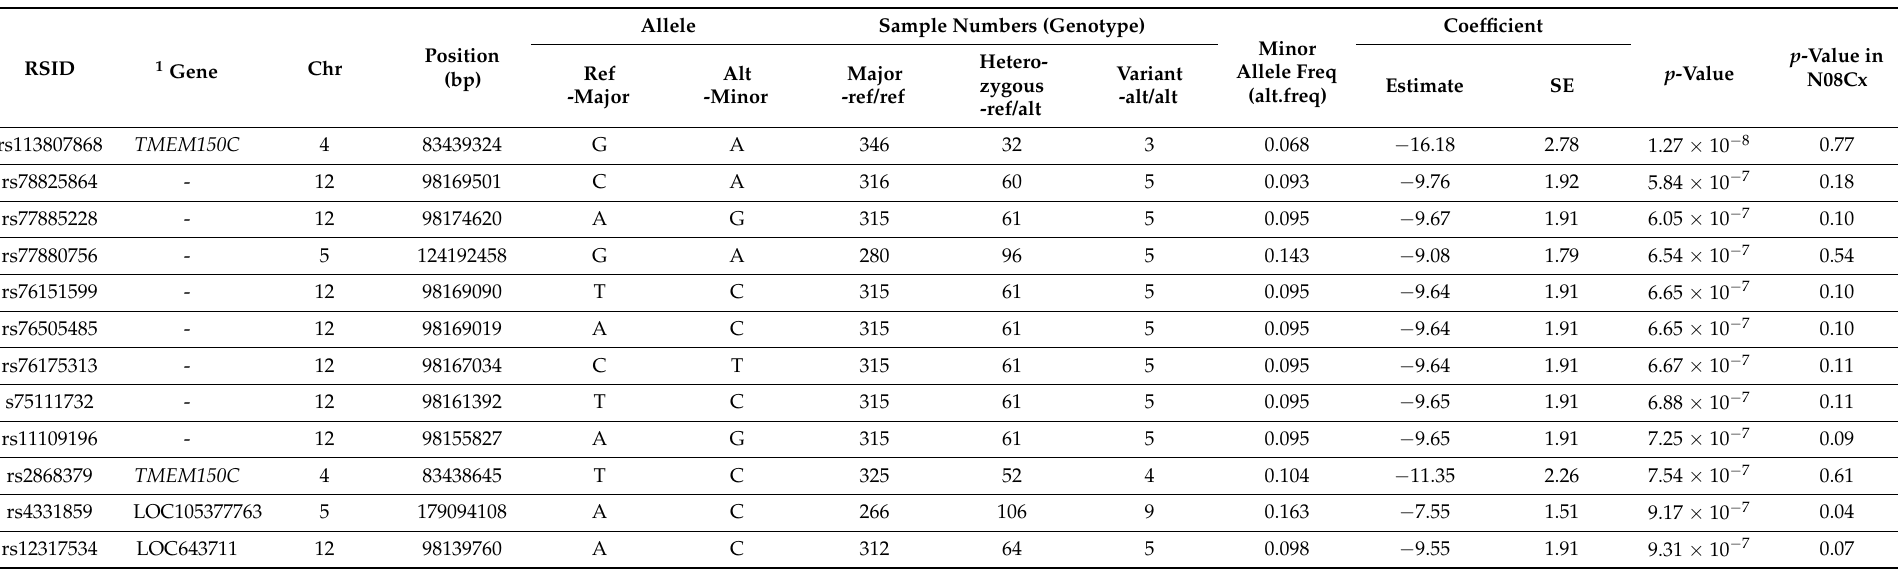
Table 6. SNPs with p -value < 1 × 10 − 6 associated with CIPN in the MCBDR cohort